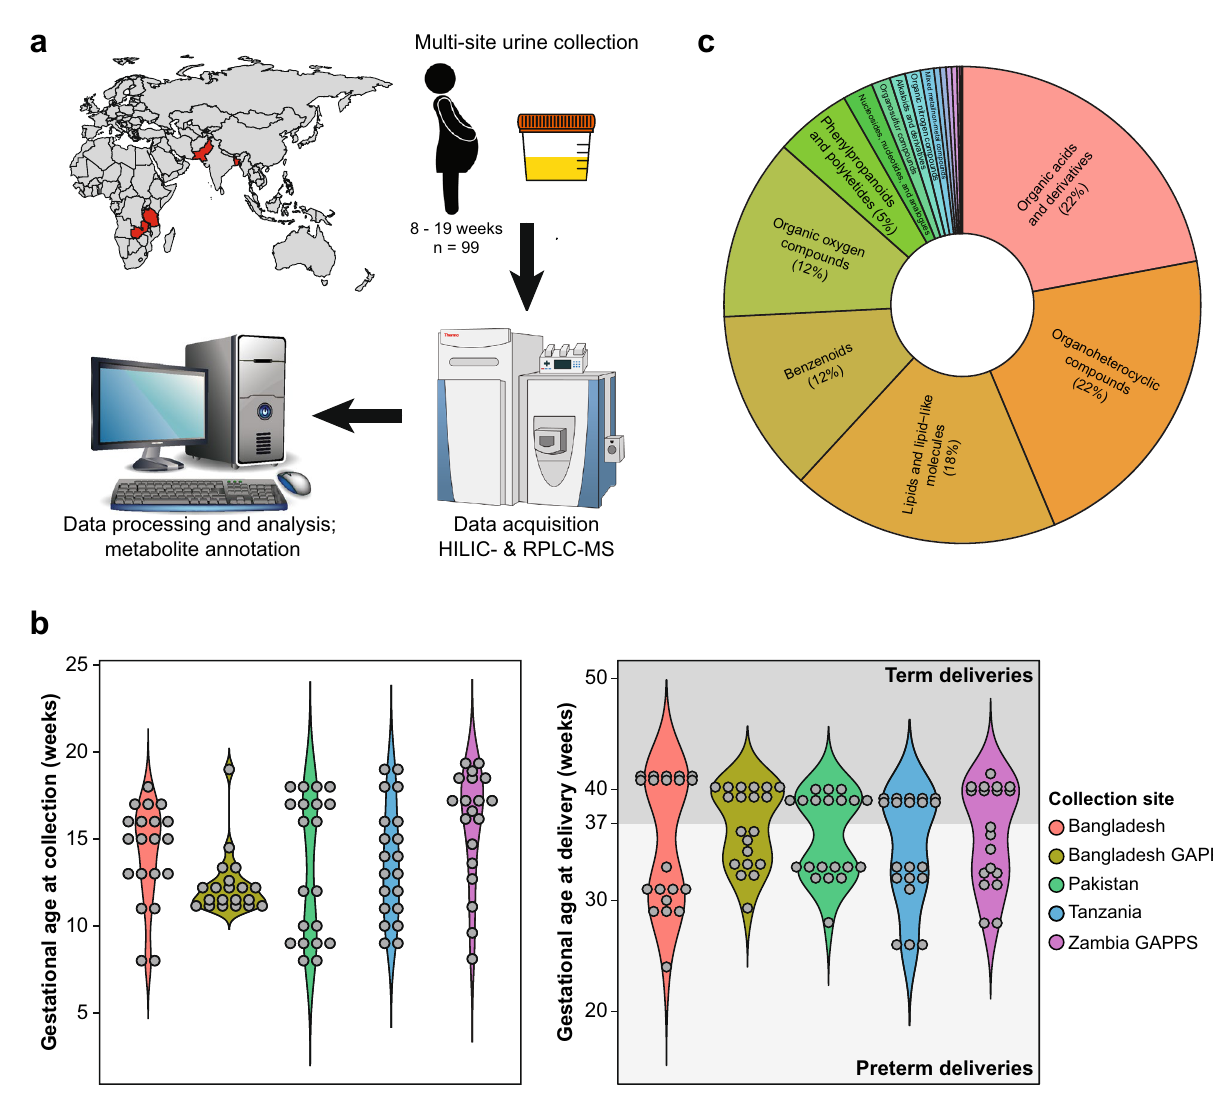
Figure 1. Study design and cohort characteristics. ( a ) Urine samples from 99 pregnant women were collected across 5 sites and analyzed using a broad-spectrum metabolomics LC–MS platform. The sources of the images are described in the Methods section. ( b ) GA at collection and at delivery across the collection sites. Urine samples were collected early in pregnancy 8–19 weeks and 49 women delivered at term (> 37 weeks’ GA) and 50 women delivered preterm (≤ 37 weeks’ GA). ( c ) Structural categorization of detected urine metabolites according to the “Superclass level” of the ClassyFire classification